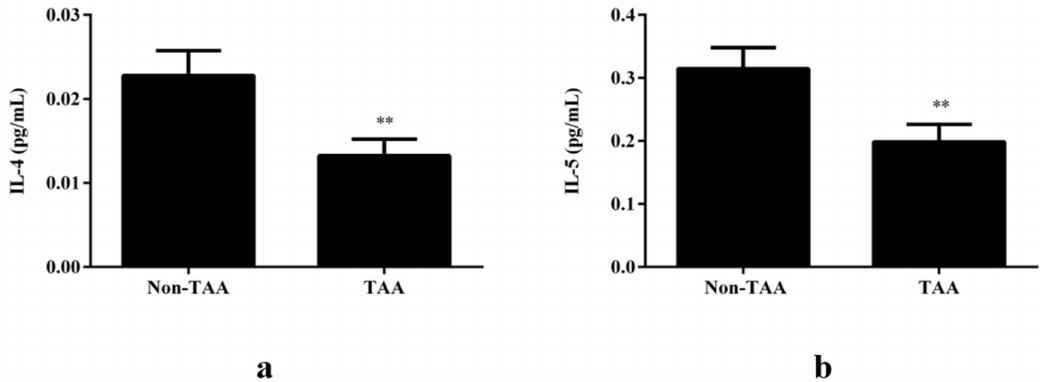
Figure 4. Th2 cytokines are downregulated in patients with TAA. ( a ) IL-4 and ( b ) IL-5 were significantly decreased in the TAA patients, compared with control patients, ** p < 0.01 (non-TAA patients; n = 49, TAA; n = 41). Comparisons between groups were performed with an unpaired t